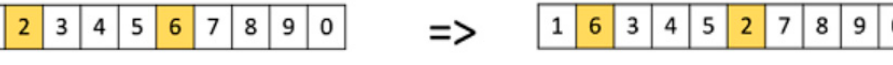
Figure 5. Solution process of improved genetic algorithm (IGA)-based stochastic unit commitment (SUC) problem.